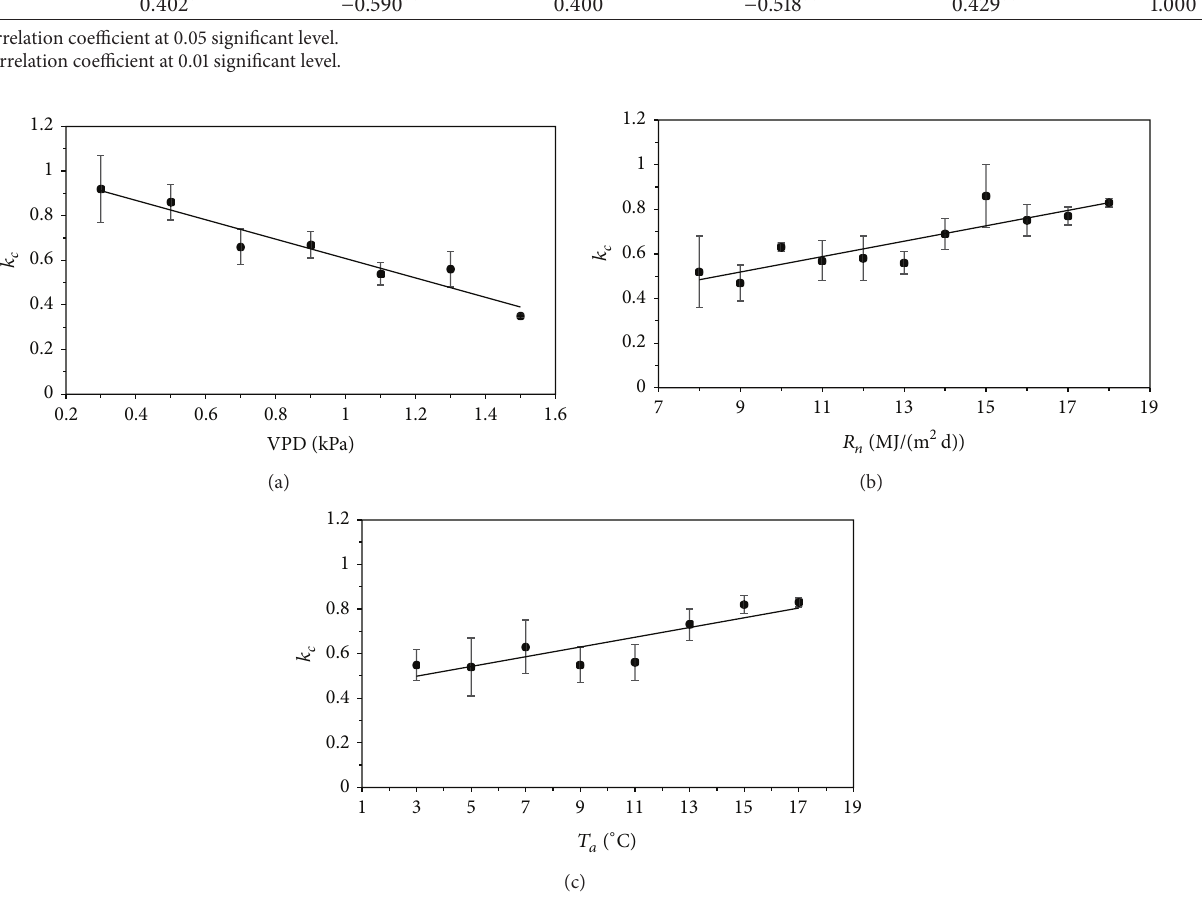
Figure 4: Linear response of 𝑘 𝑐 to (a) VPD, (b) 𝑅 𝑛 , and (c) 𝑇 𝑎 . The daily 𝑘 𝑐 data were averaged with a bin width of 0.2 kPa for VPD, 1MJ/(m 2 d) for 𝑅 𝑛 , and 2 ∘ C for 𝑇 𝑎 , respectively. Bars indicate mean ±